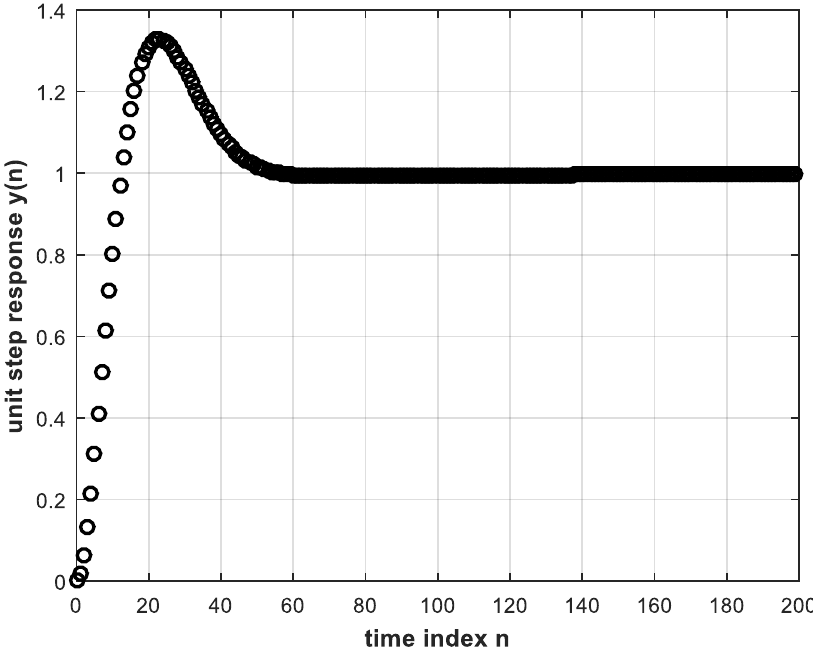
Figure 7. Unit step response of feedback control system using the trained DL controller with two hidden layers.